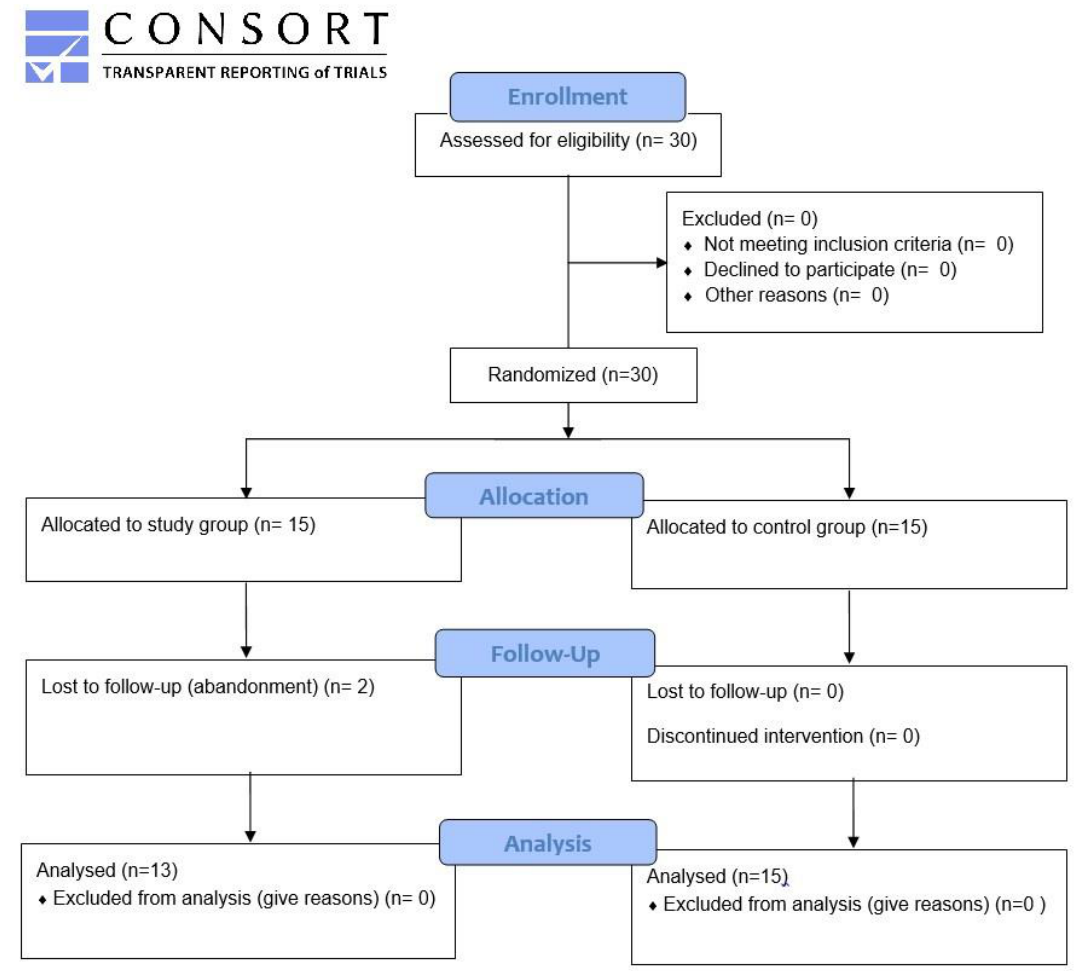
Figure 1. Flow chart.